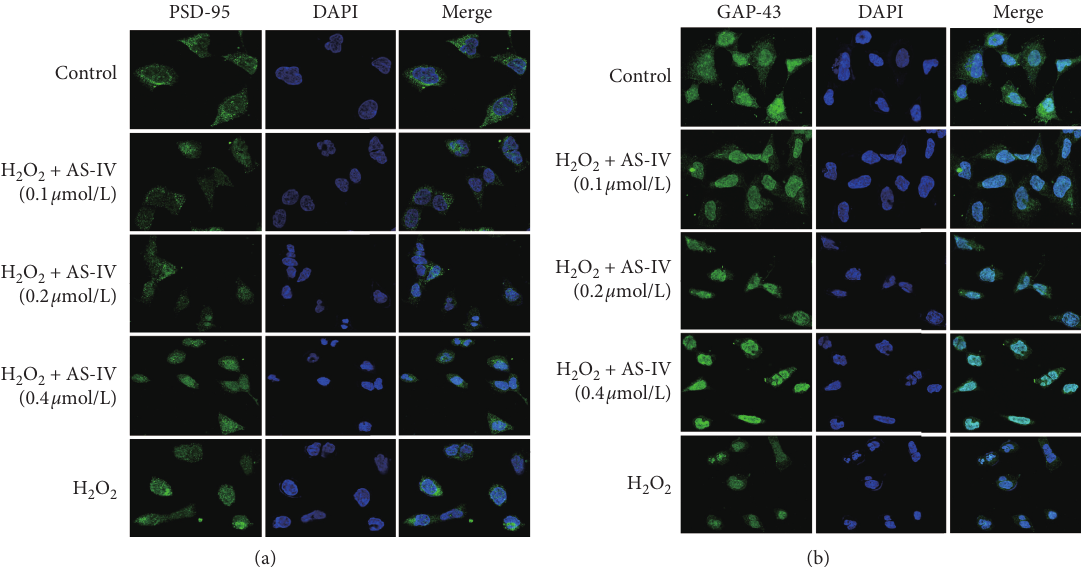
Figure 4: Immunofluorescence expressions of synaptic markers PSD-95 and GAP-43. (a) Expression of PSD-95 under H treatment 3h after AS-IV (0.1 ∼ 0.4 μ mol · L − 1 ) pretreatment for 2h. (b) Expression of GAP-43 under H 2 O 2 (50 μ mol · L − 1 ) treatment 3 h after AS-IV (0.1 ∼ 0.4 μ mol · L − 1 ) pretreatment for 2